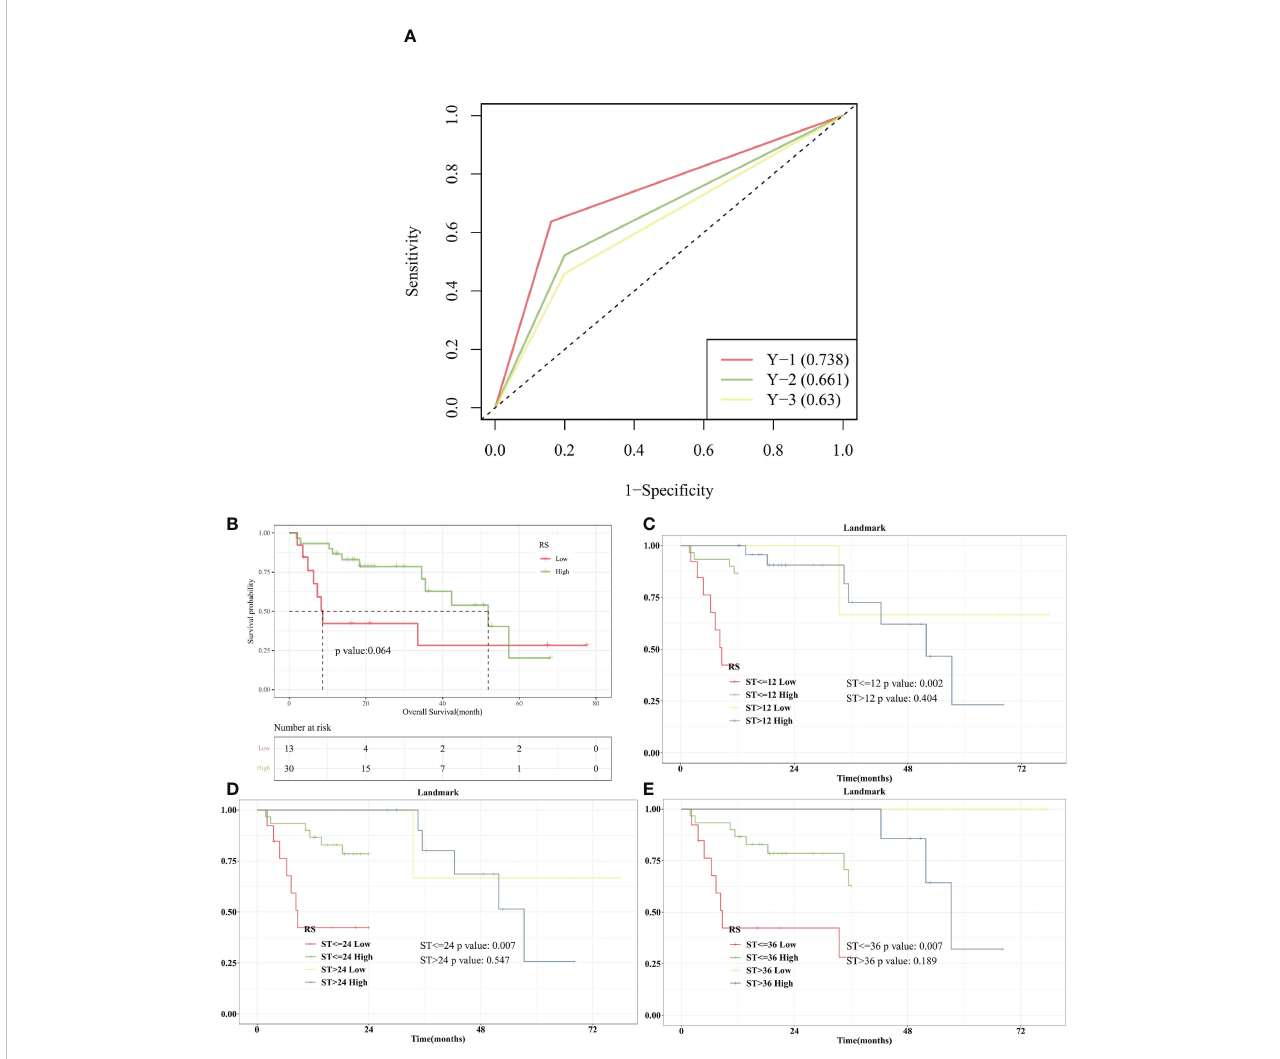
FIGURE 8 Survival Analysis with RS in BLCA. (A) . The AUC value of RS expression in predicting OS (12 months) was 0.738; (B) . Kaplan-Meier curves displayed that higher RS expression was critically associated with improved OS; (C) . With 12 months after diagnosis as Landmark, higher RS was associated with improved early-stage survival signi fi cantly (P = 0.002). (D) . With 24 months after diagnosis as Landmark, higher RS was associated with improved early- stage survival signi fi cantly (P = 0.007). (E) . With 36 months after diagnosis as Landmark, higher RS was associated with improved early-stage survival signi fi cantly (P =